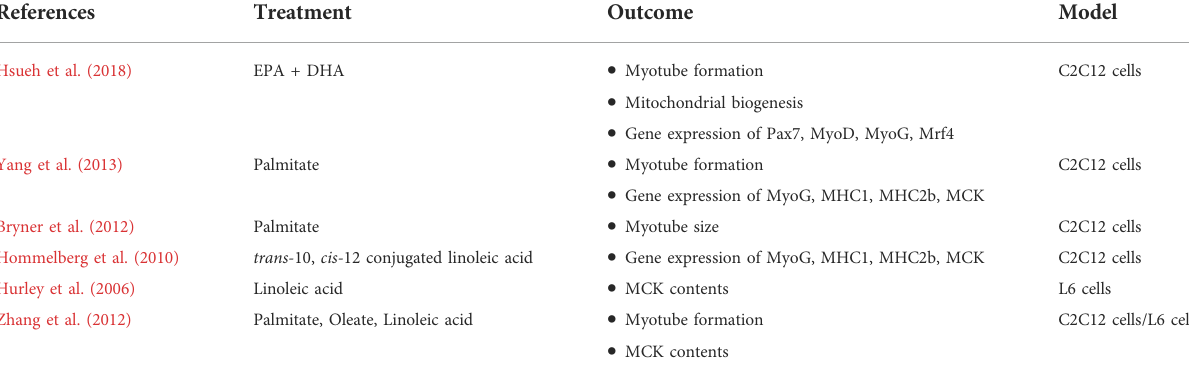
TABLE 1 A summary of studies investigated the inhibitory effects of FFAs on skeletal muscle